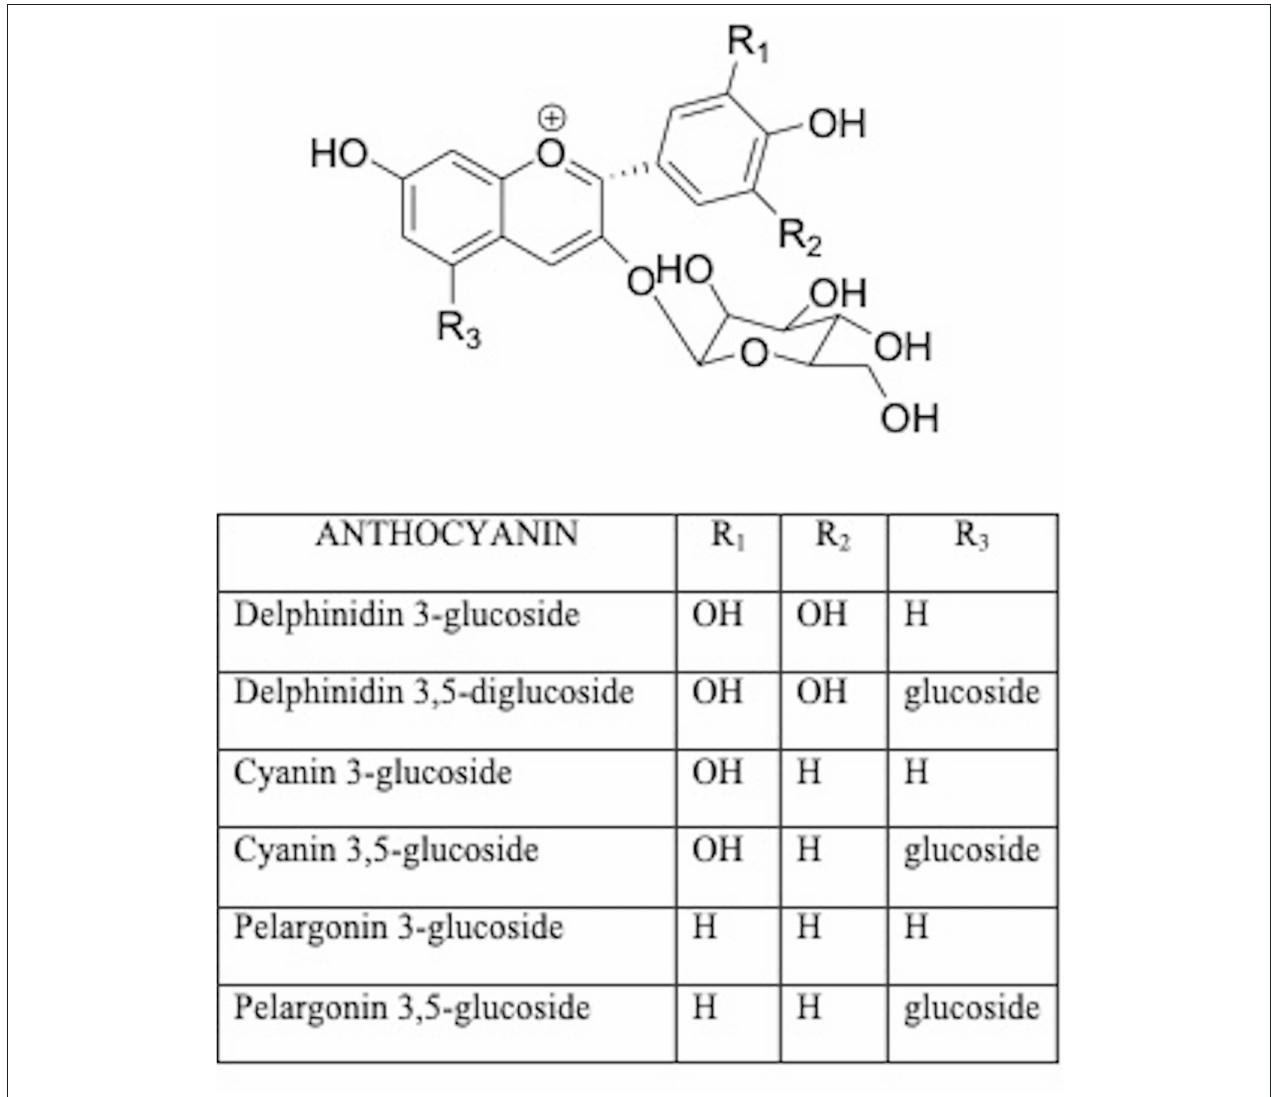
FIGURE 3 | Structures of main